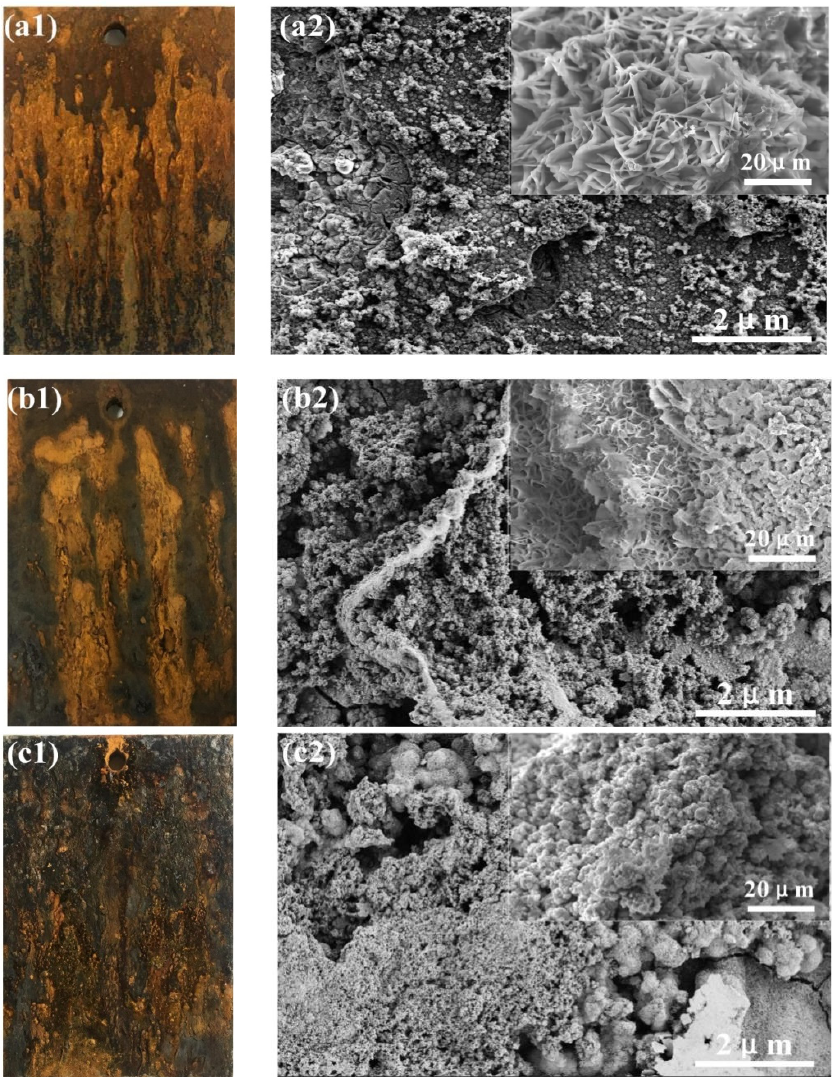
Figure 4. Surface macro ( a1 – c1 ) and micro ( a2 – c2 ) morphology of corrosion products of medium-Mn steel at different corrosion stages: ( a1 , a2 ) 72 h; ( b1 , b2 ) 288 h; ( c1 , c2 ) 600 h.